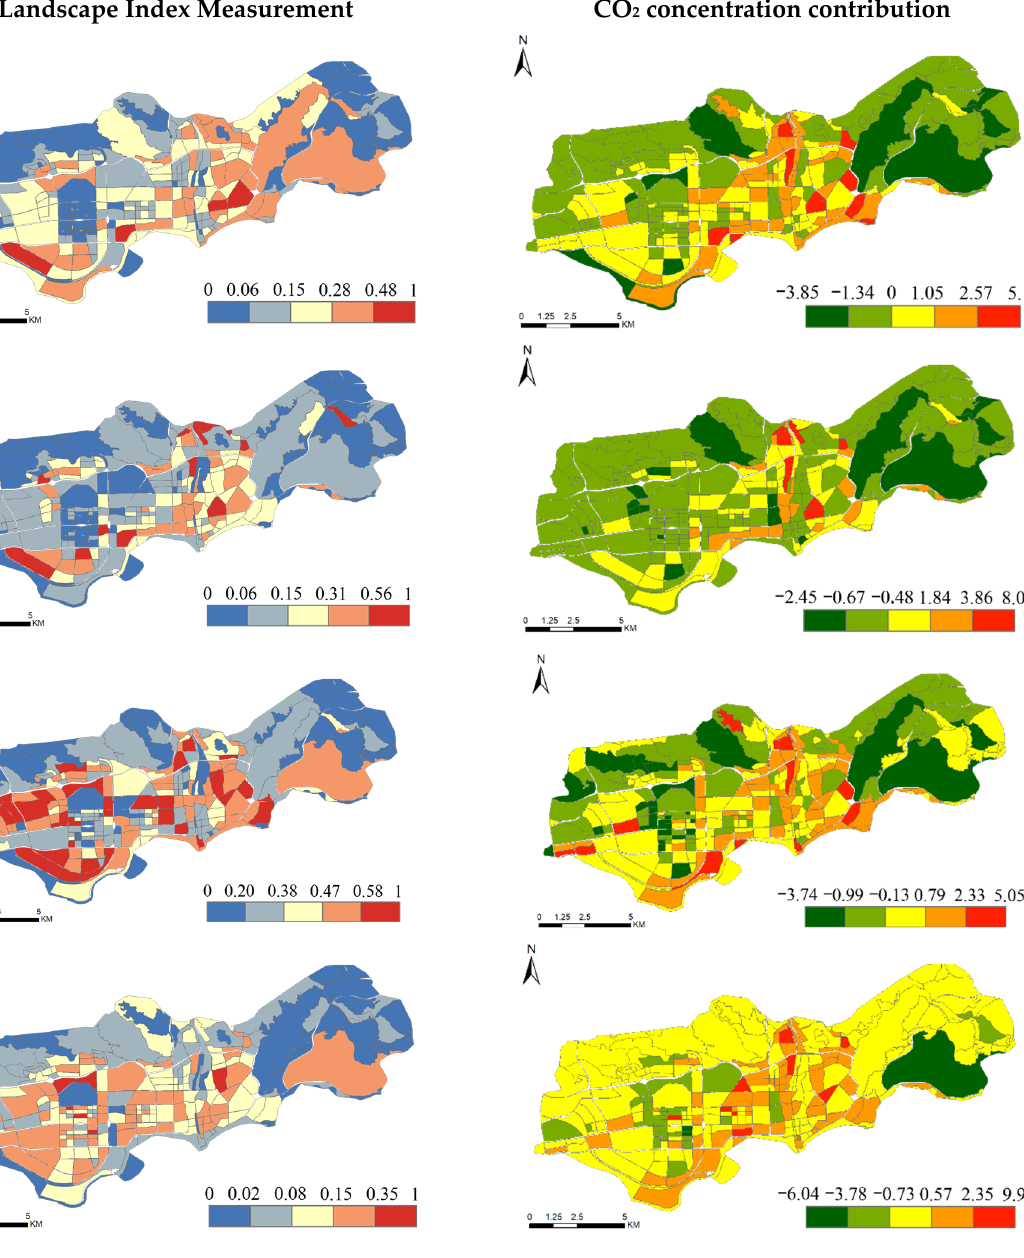
Figure 9. Landscape Index Measurement and CO 2 concentration contribution